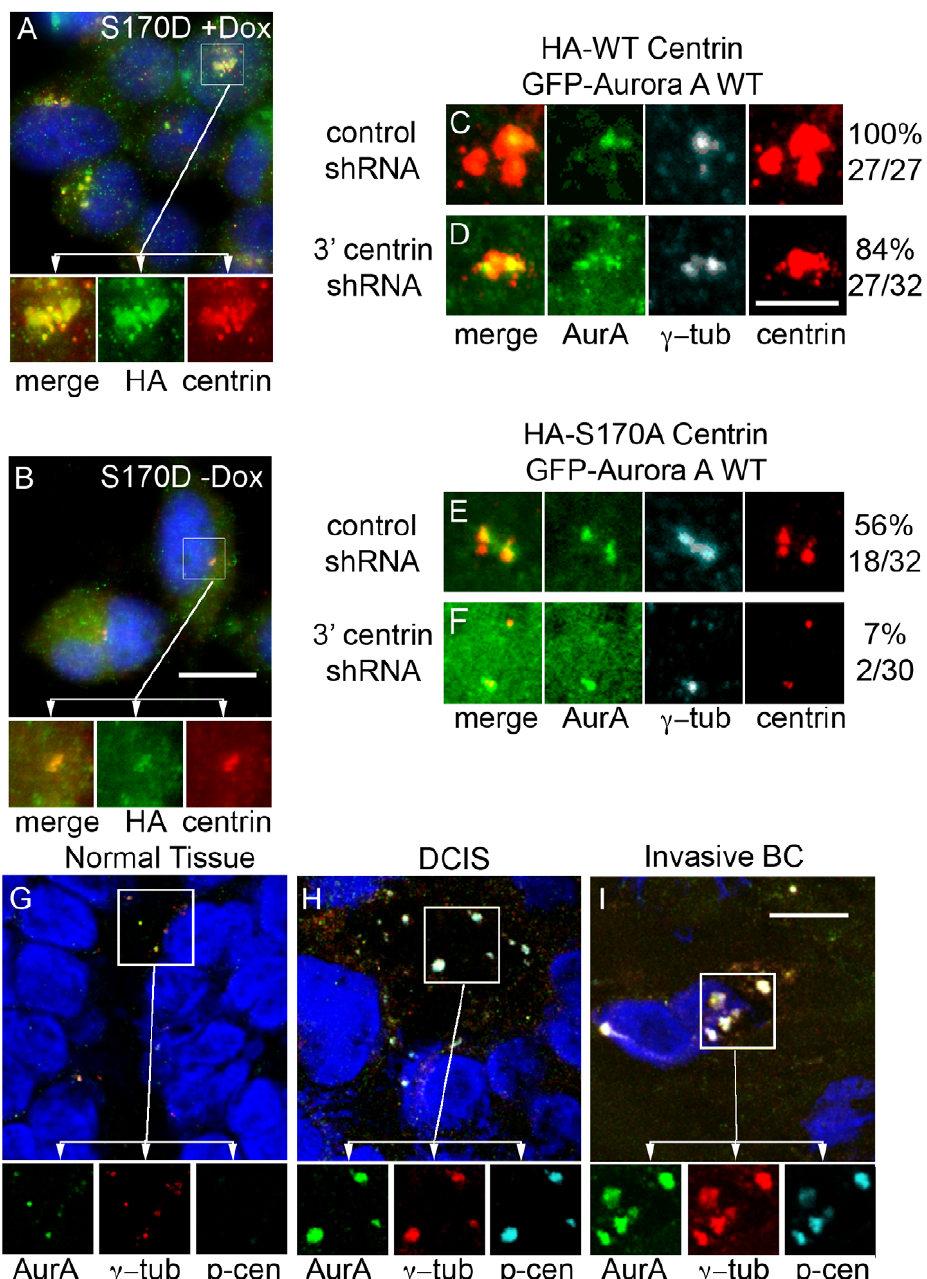
Figure 4. S170D-centrin drives centrosome amplification. (A) Constant expression of S170D-centrin drives centrosome amplification in HeLa Tet-On S170D-centrin cells treated continuously with doxycycline. Cells were stained with an antibody against HA (green) and a polyclonal antibody against centrin (red). Scale bar=10 microns. (B) Cells that were not induced with doxycycline have normal centrosomes. Cells were stained as in panel (A). Scale bar=10 microns. (C–F) HeLa Tet-On HA-WT-centrin or HA-S170A-centrin cells transfected with GFP-WT Aurora A and allowed to recover for 24 hours. Cells were then transfected with control shRNA or centrin shRNA and treated with doxycycline to induce HA-centrin expression. Aurora A expression was noted by GFP positivity and cells were stained with centrin (red) and gamma-tubulin (turquoise). A vector control Western blot is shown in Figure S3. Cells over-expressing HA-wildtype centrin in the presence of endogenous centrin have large, numerous centrosomes (C) in virtually all cells. Cells over-expressing HA-wildtype centrin in the absence of endogenous centrin have large, numerous centrosomes (D) in most cells. Conversely cells over-expressing HA-S170A centrin in the presence of endogenous centrin occasionally have slightly enlarged centrosomes (E) and cells over-expressing HA-S170A centrin in the absence of endogenous centrin rarely have slightly enlarged centrosomes (F). GFP positive cells were analyzed for centrosome amplification based on increased size and/or number of centrosomes. The number and percentage of cells with centrosome amplification is presented below each panel. Scale bar=2.5 microns. (G–I) Frozen breast tissue including normal adjacent breast (G), ductal carcinoma in situ (H) and invasive breast cancers (I) were stained with antibodies directed against Aurora A (green), p-S170 centrin (turquoise), and gamma-tubulin (red). Cells were stained with DAPI to mark the DNA. Scale bar=10 microns.